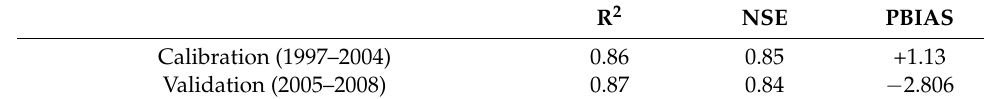
Table 11. Model performance evaluation statistics.